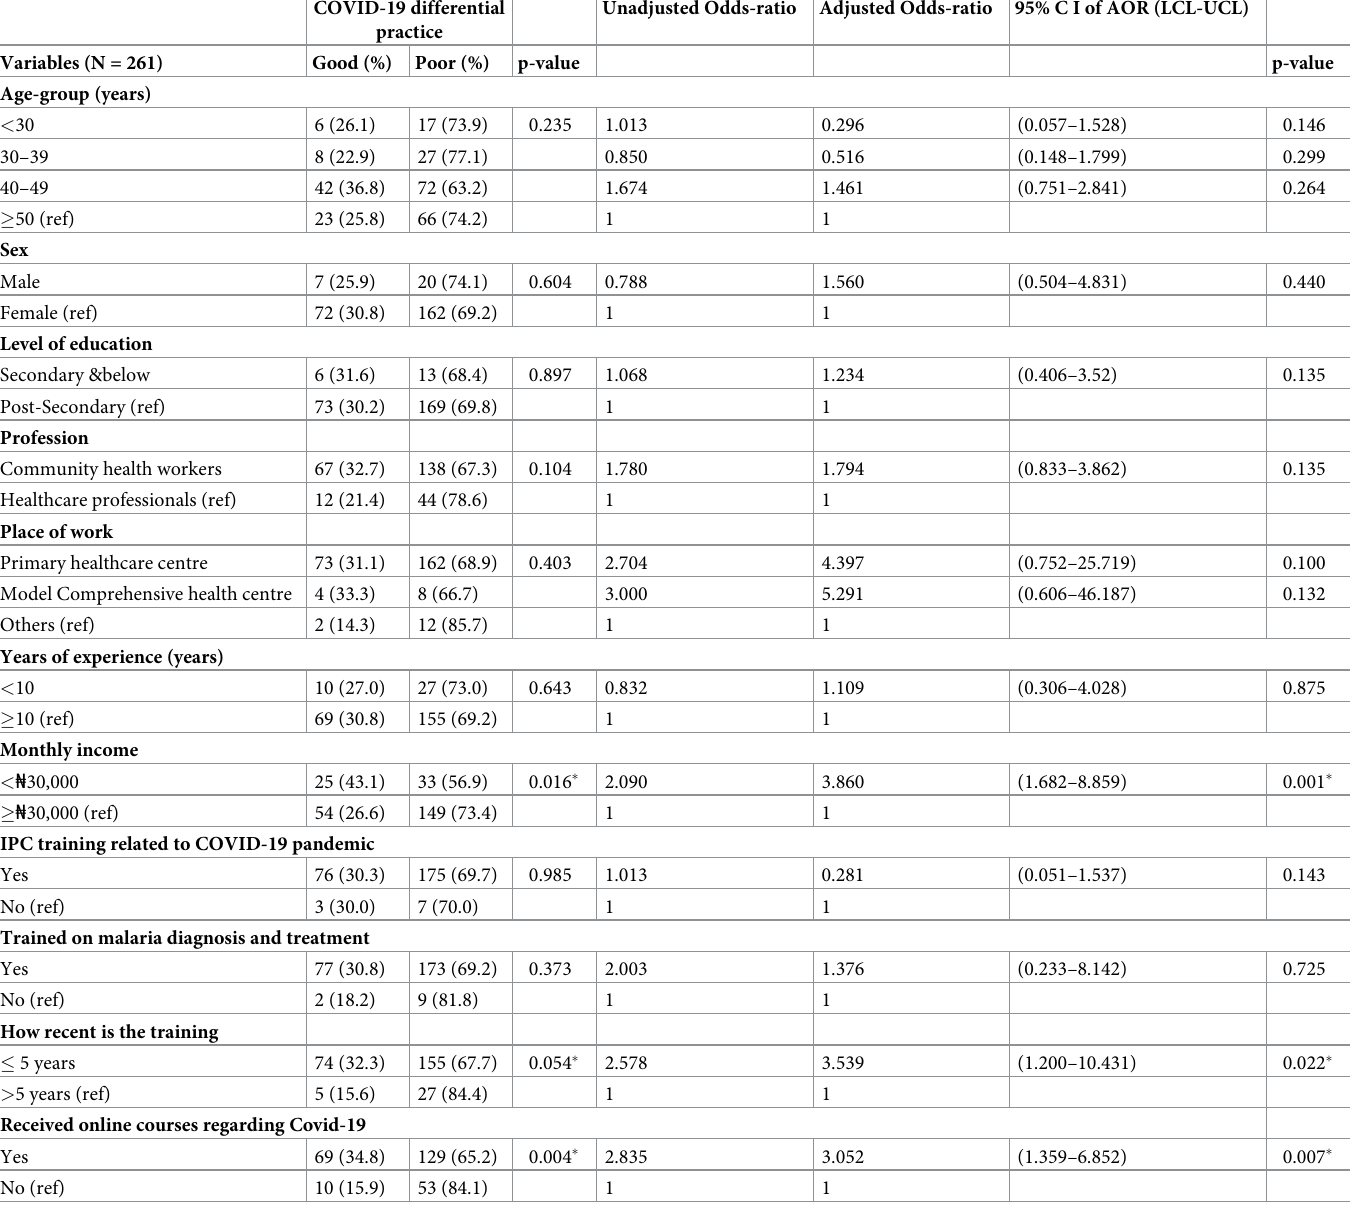
Table 5. Factors influencing COVID-19 differential practice of healthcare